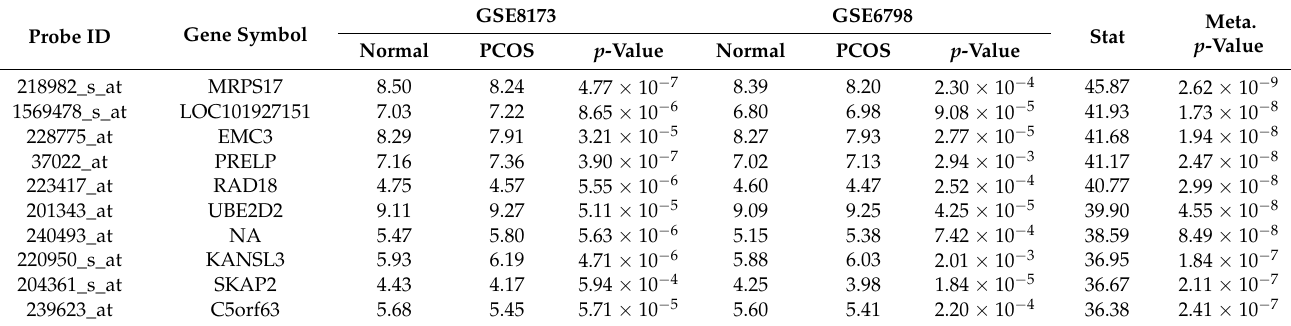
Table 1. Top 10 significant results in the meta-analysis of differentially expressed